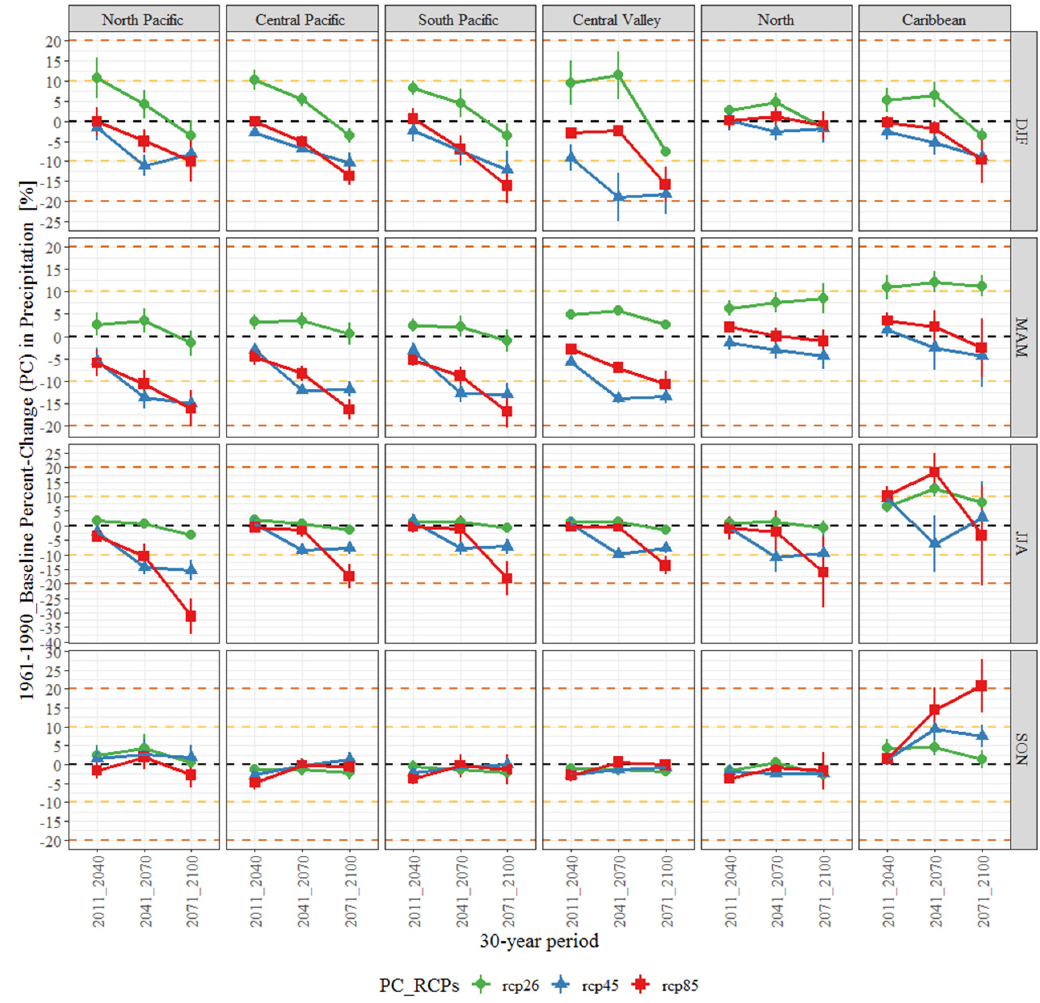
Figure 11. Spatially-averaged percentage-change (PC) in precipitation of the bias corrected ensemble-mean with respect to baseline period (1961–1990) under RCPs 2.5, 4.5 and 8.5 for near-future, mid-future and far-future periods over all climatic regions of Costa Rica.